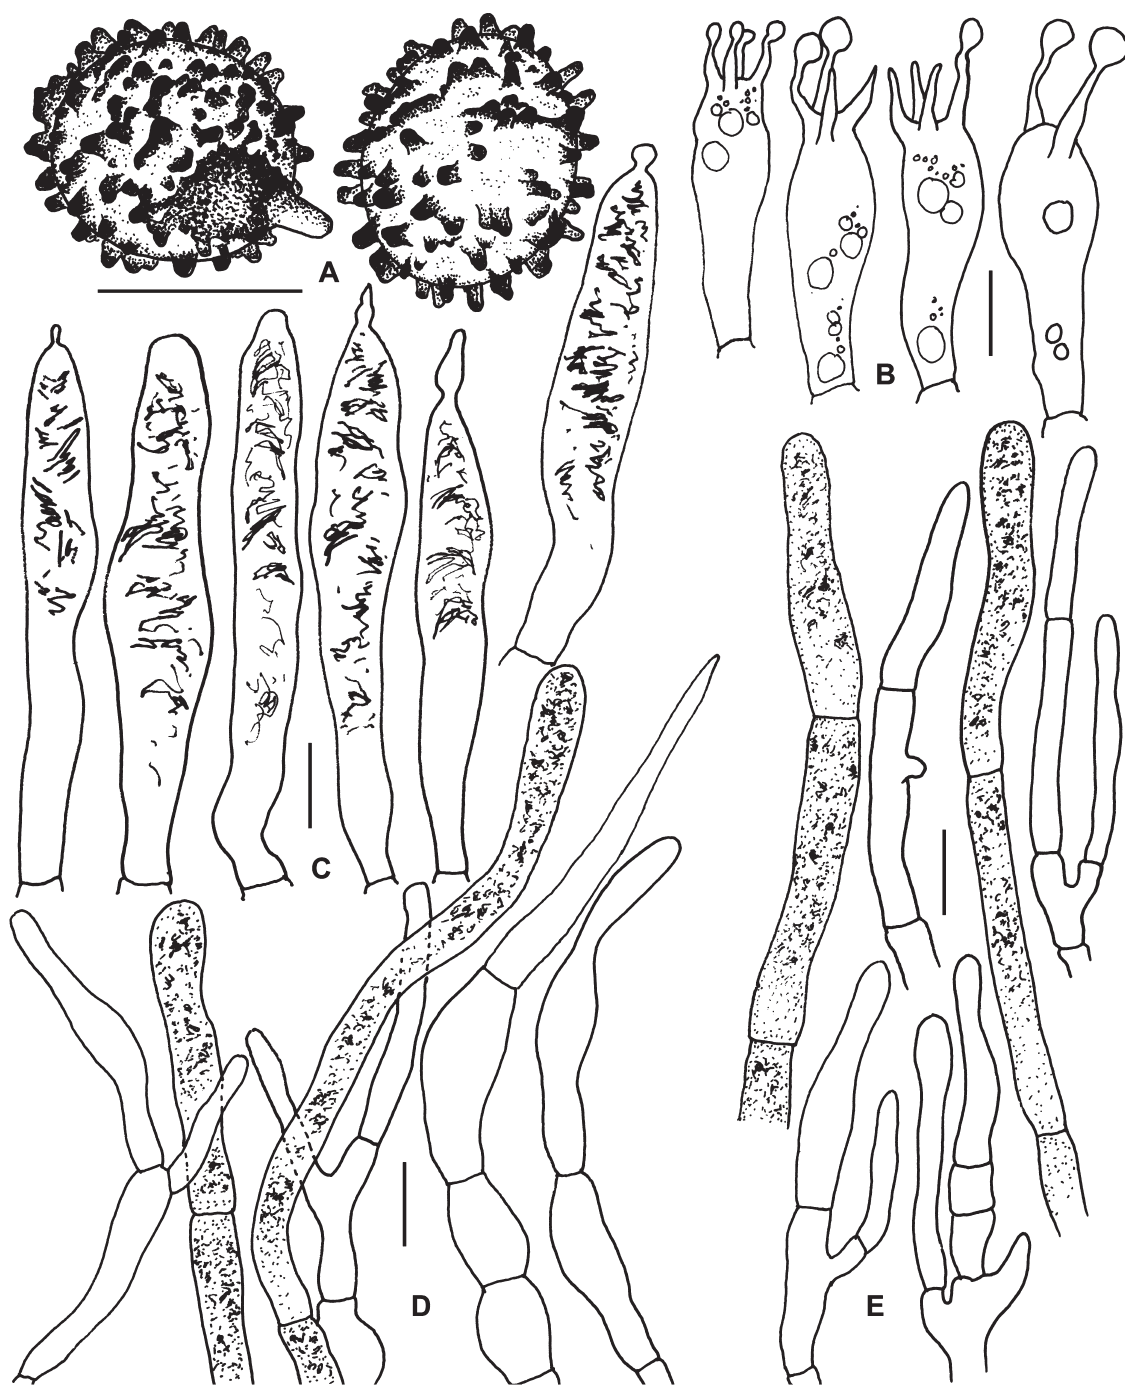
Fig. 5. Russula purpureozonata K.Das, A.Ghosh & Buyck sp. nov. (from holotype, KD 18-003 ). A. Basidiospores. B. Basidia. C. Hymenial cystidia near the lamellae sides. D. Elements of the pileipellis near the pileus centre: hyphal terminations and pileocystidia. E. Elements of the pileipellis near the pileus margin: hyphal terminations and pileocystidia. Scale bars: A = 5 μm; B–E = 10